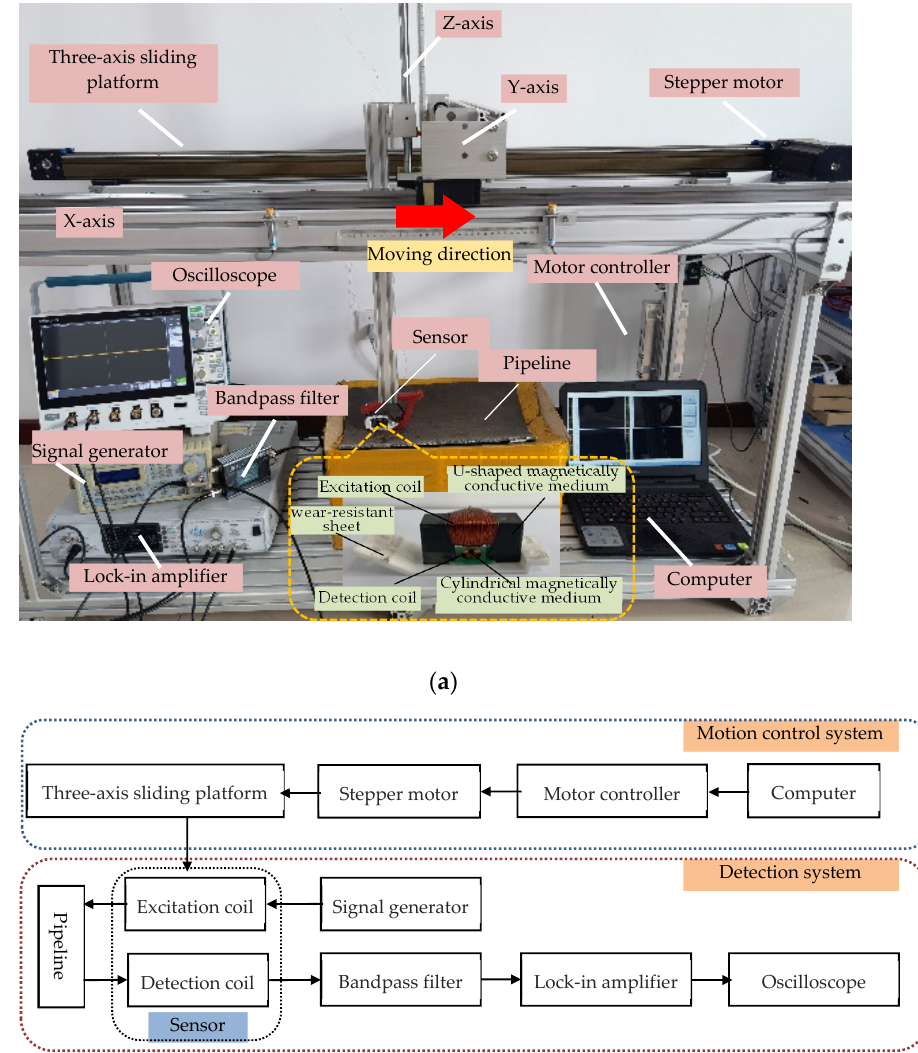
Figure 9. ( a ) Balanced-field electromagnetic technique crack detection experimental platform; ( b ) the working principle of the experimental platform.